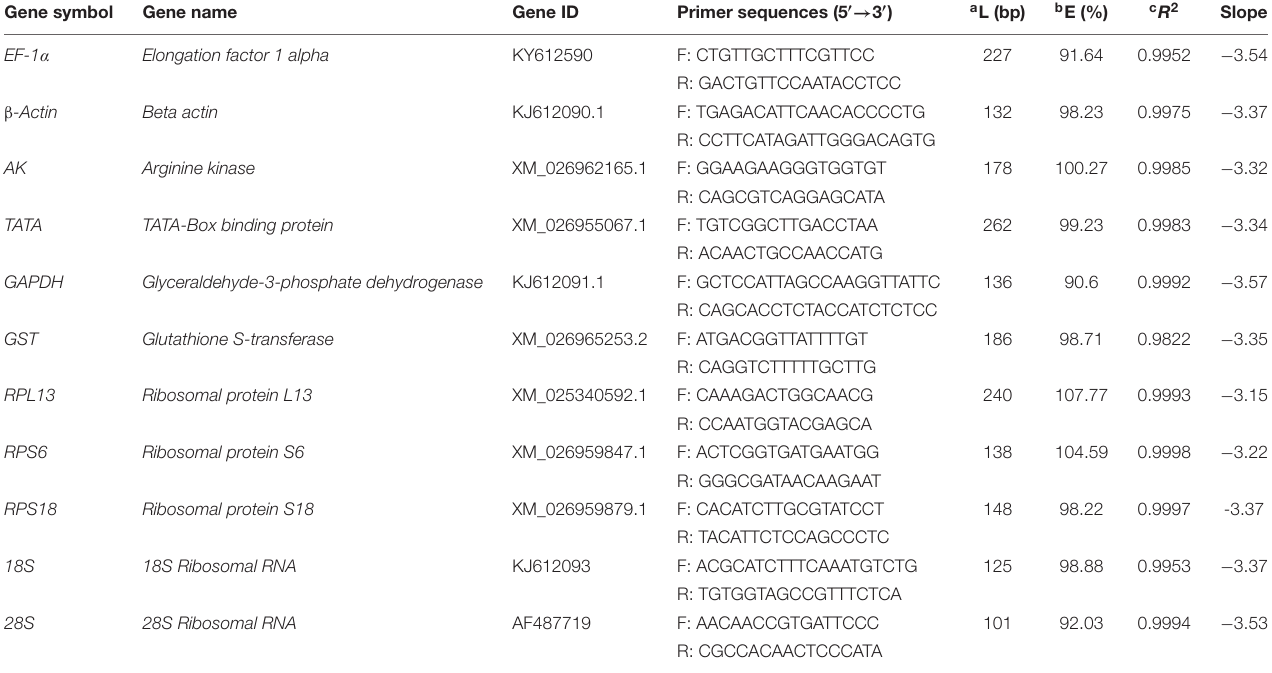
TABLE 1 | Primer sequences and amplicon characteristics of the 11 reference genes in R. padi samples.